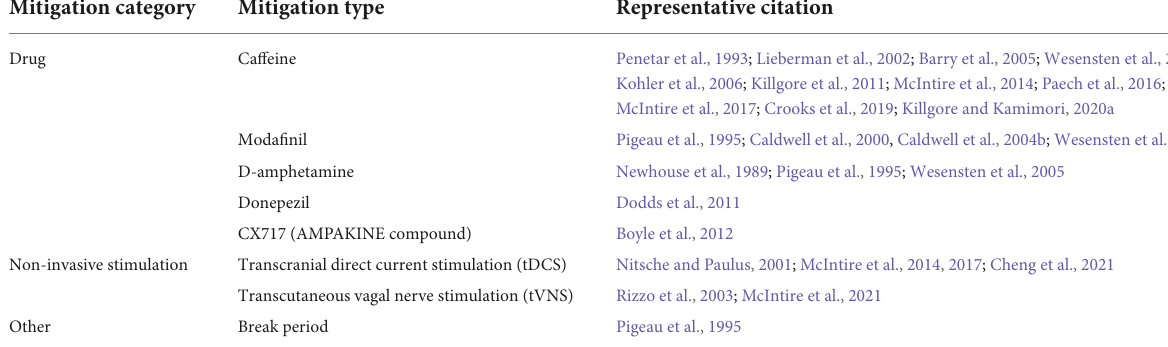
TABLE 4 Summary of different types of fatigue